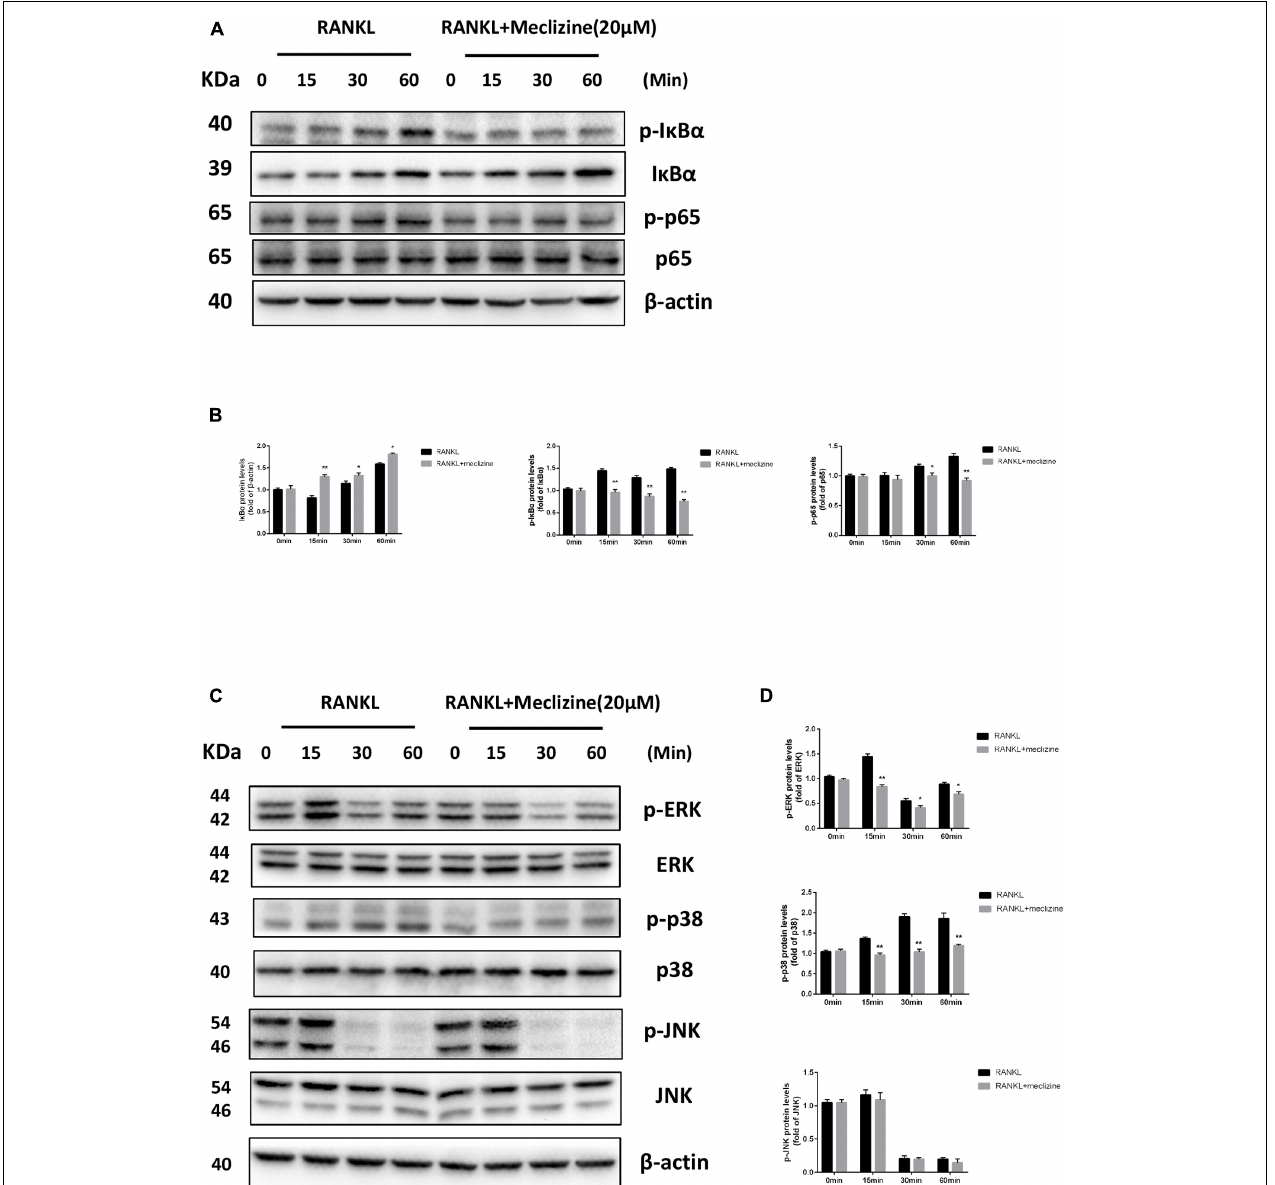
FIGURE 7 | Meclizine represses RANKL-induced NF- κ B and MAPKs in BMMs. (A,B) Meclizine inhibits NF- κ B activation. BMMs were starved with α -MEM in the absence of FBS for 12 h, and then pretreated with or without meclizine (20 µ M) for 1 h. Subsequently, BMMs were treated with or without RANKL (100 ng/mL) for the indicated times. The total proteins were extracted for immunoblotting with the indicated antibodies. (C,D) The effect of meclizine on RANKL-induced phosphorylation of ERK, p38 and JNK. BMMs were treated as described above, and total proteins were extracted for immunoblotting with MAPKs antibodies. The experiments were repeated three times independently and the total protein was used as a loading control. ∗ P < 0.05, ∗∗ P < 0.01 versus RANKL